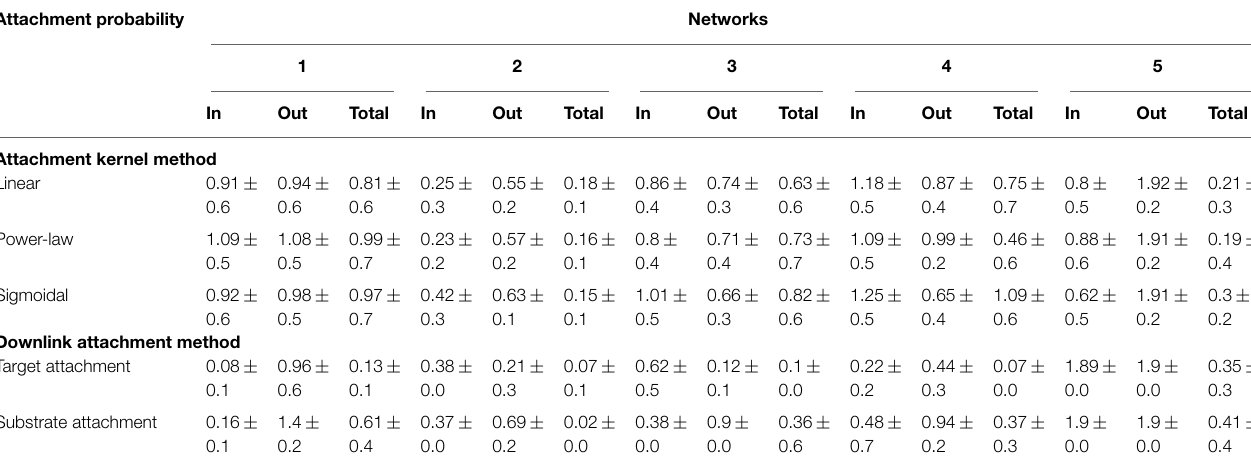
TABLE 4 | Statistics for the difference between power-law exponents of candidate and target network’s degree distributions resulting from either the attachment kernel method reported in Mayo et al. (2012), or from the downlink attachment method reported here . Attachment probability